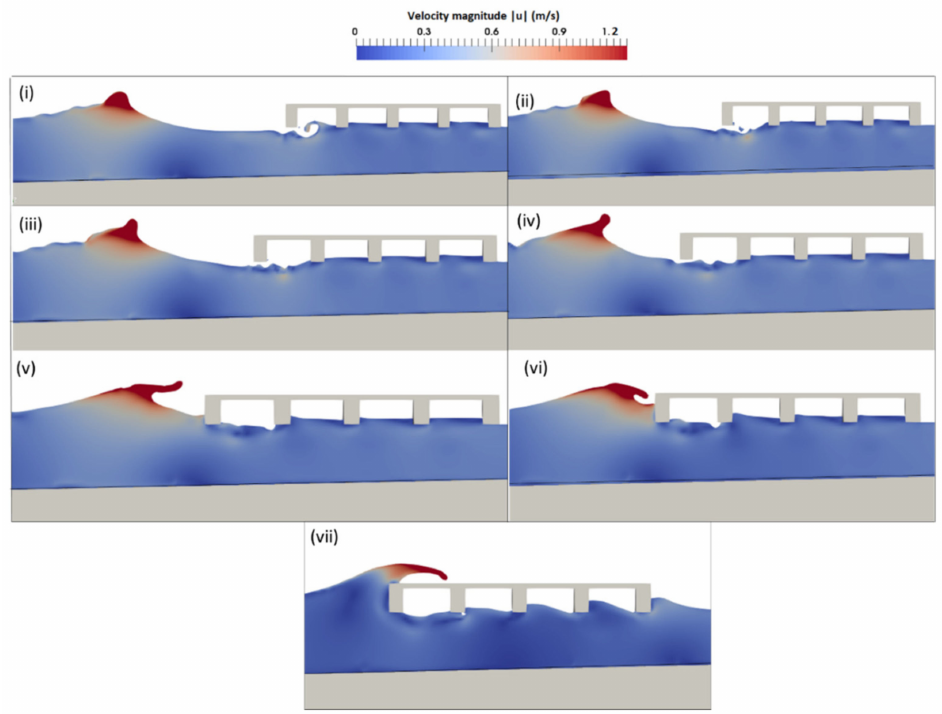
Figure 13. Velocity variation during breaking wave impact scenario WI-3 with the coastal deck struc- ture at normalized airgap ( S/d = 0.18) at different time steps ( i ) t = 16.1 s ( ii ) t = 16.2 s ( iii ) t = 16.25 s ( iv ) t = 16.35 s ( v ) t = 16.45 s ( vi ) t = 16.5 s ( vii ) t = 16.7